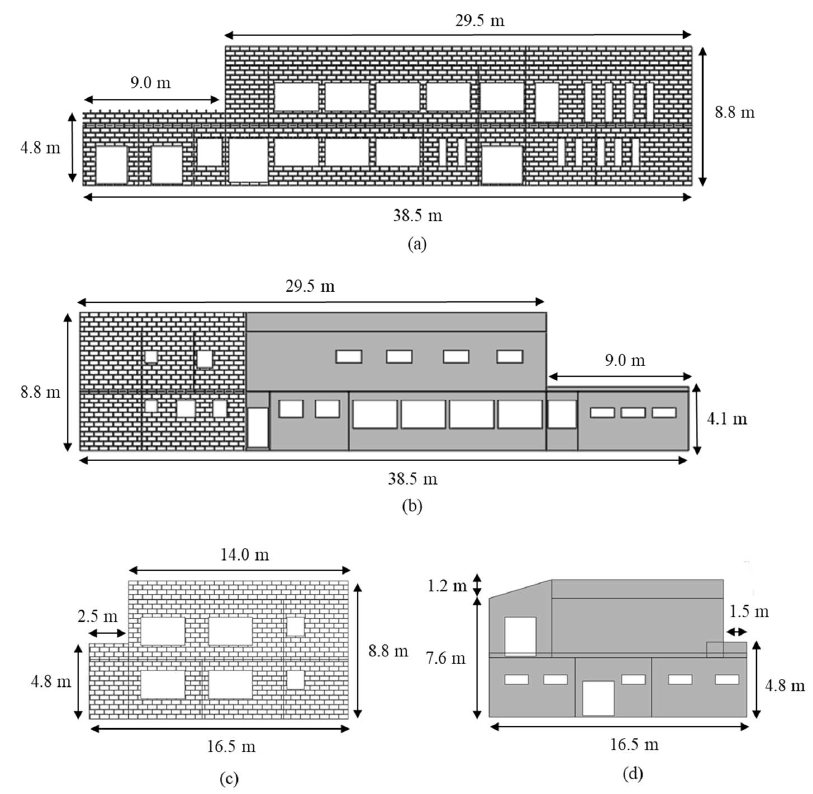
Figure 2. Specification of the office building (126°65′ E, 34°78′ N) located at Yeongam–gun, Jeollanam–do, Korea: ( a ) front view (north wall), ( b ) rear view (south wall), ( c ) side view (west wall), and ( d ) side view (east wall).